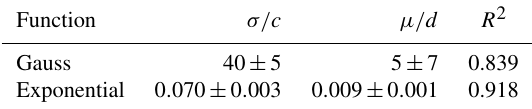
Table 1. Parameters obtained by fitting the Gaussian and exponen- tial functions to the counts in the event-event distance distribution for the Italian catalog. The last column shows the R 2 of the